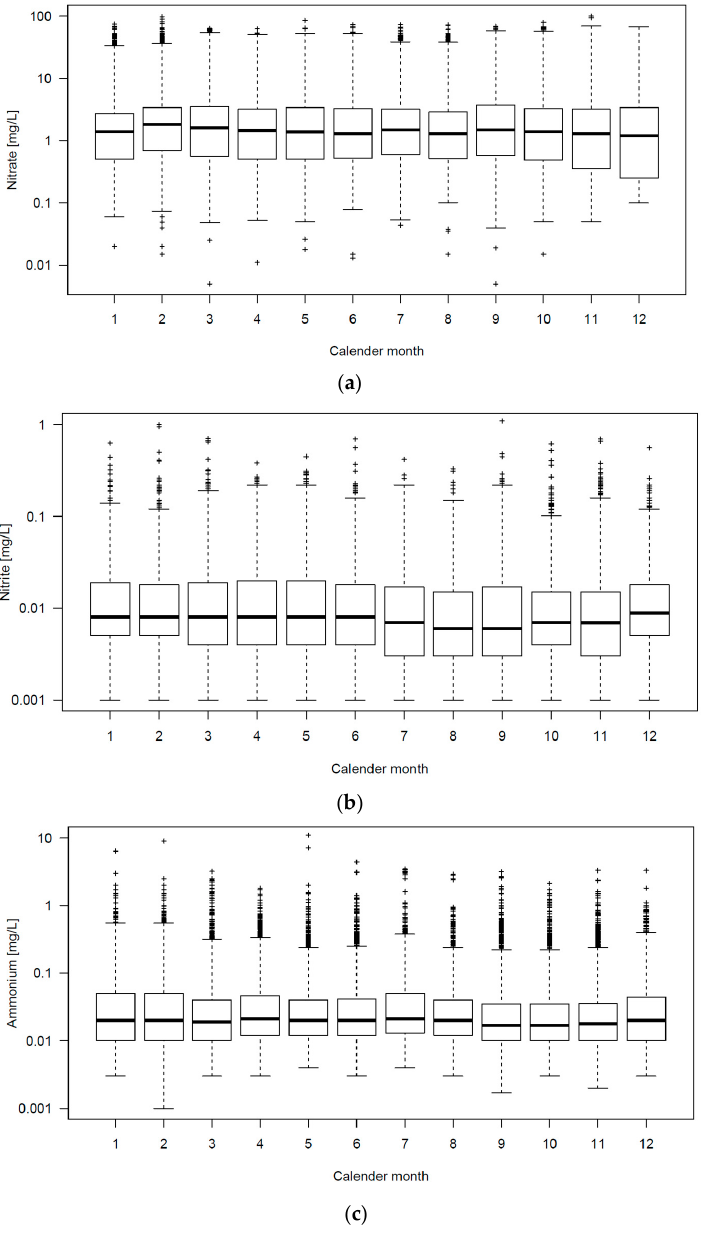
Figure 5. Box and whisker plots of: ( a ) Nitrate ( N = 42,823); ( b ) Nitrite ( N = 54,859); ( c ) Ammonium ( N = 47,052) concentrations in public supplies by calendar